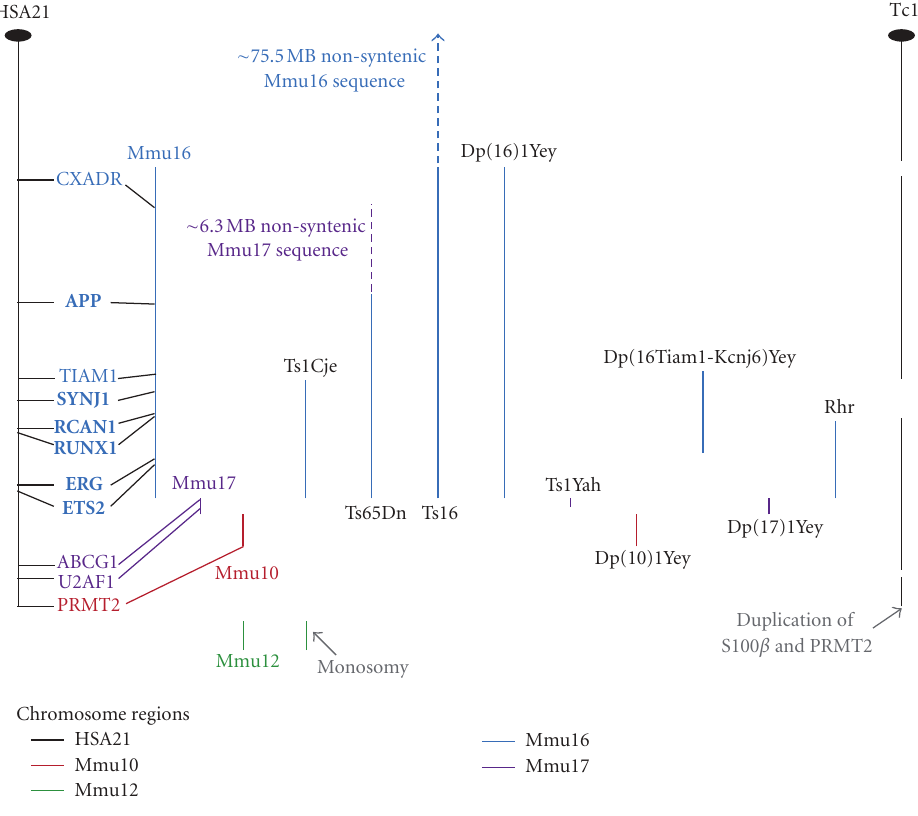
Figure 1: A graphical representation of HSA21 and the syntenic mouse chromosome regions from Mmu10, Mmu16, and Mmu17. The trisomic (or monosomic) chromosome regions present in 10 of the segmental mouse trisomies are also shown, with color-coding indicating the chromosome source of the region (see the key in the figure). The location of 11 HSA21 genes is shown, as well as their location on the syntenic chromosome regions, with text color indicating which syntenic chromosome. The dark ovals indicate the HSA21